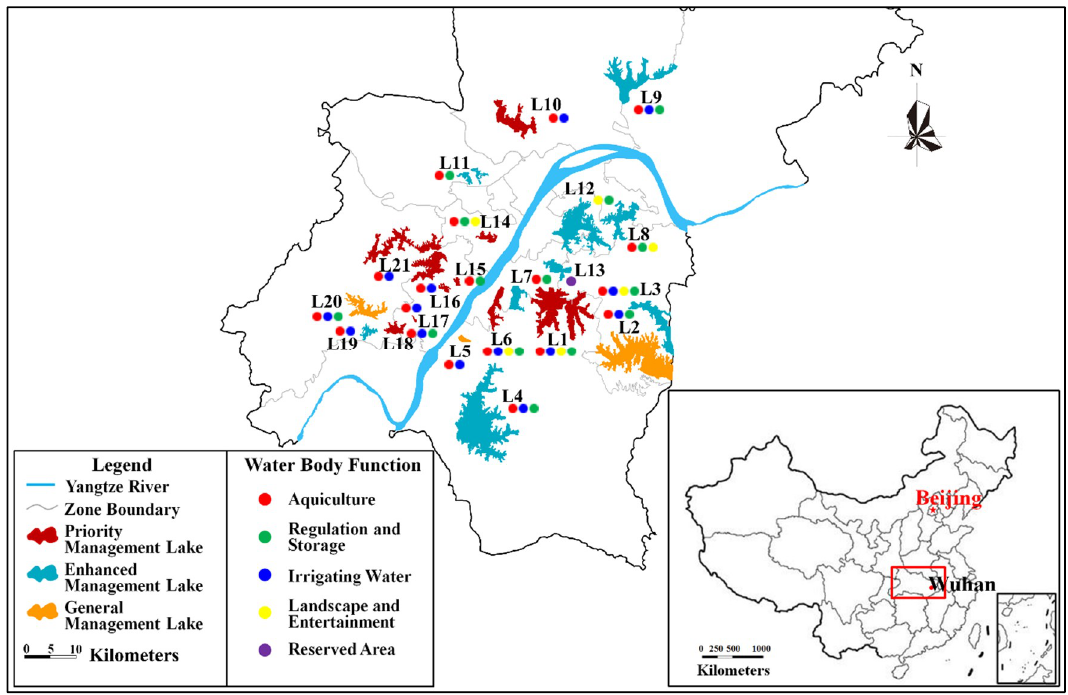
Figure 2. Management classification chart of 21 investigated lakes (ArcGIS software version 9.3 (https://www.arcgis.com/index.html)).